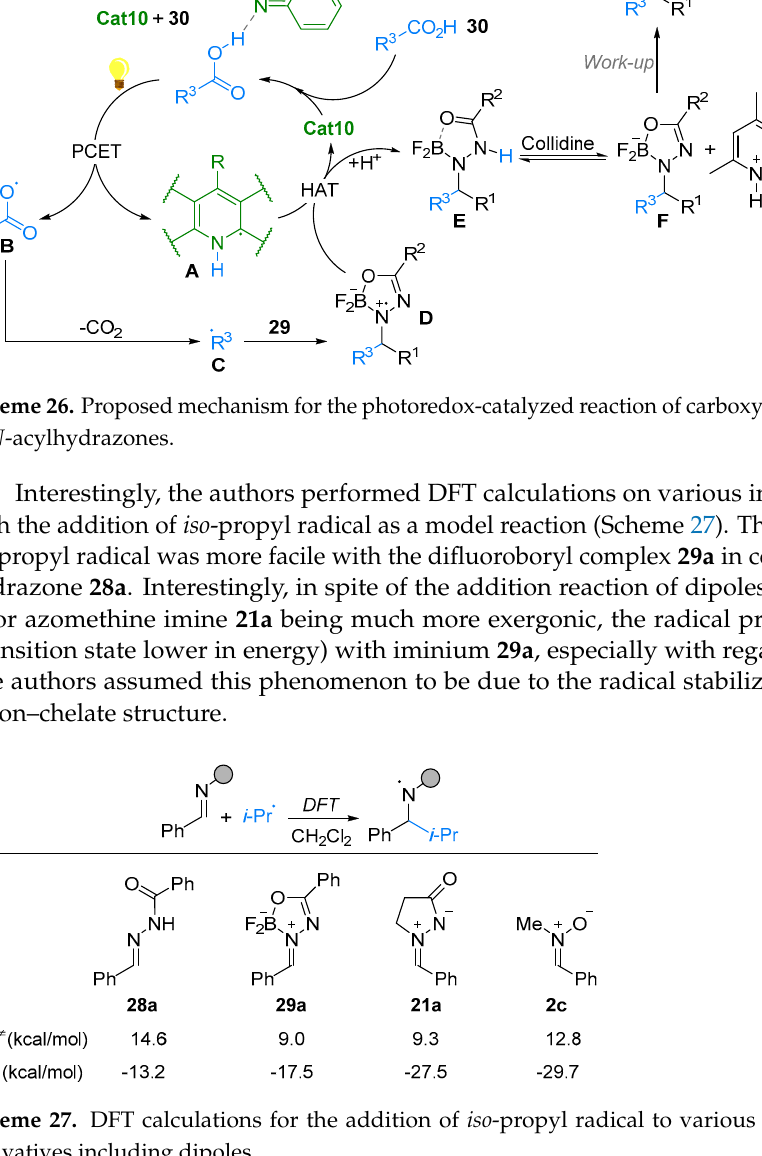
Figure 5. Radical-based transformations of pyridinium N -oxides. In 2016, Han, Pan and coworkers reported the deoxygenative C2-sulfonylation reac- tion of quinoline N -oxides 32 in the presence of sodium sulfinate 33 and potassium per- sulfate as the radical initiator and catalyzed by copper(II) bromide (Scheme 28) [45]. Var- iation in the substituents on the sulfinate and quinoline moieties were carried out with aryl ( 34a – e ), alkyl ( 34f ) and heteroaryl ( 34g ) groups tolerated for the first one and methyl and halogens groups ( 34h – j ) for the latter ones. Remarkably, exclusive formation of C2- functionnalized products was observed, regardless of the substitution pattern on the aza- cycles 32 .